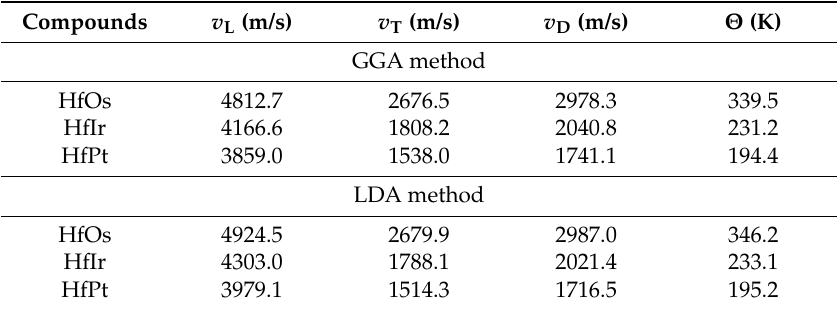
Table 6. Sound velocity (m/s) and Debye temperature (K) for HfX (X = Os, Ir and Pt). Compounds v L